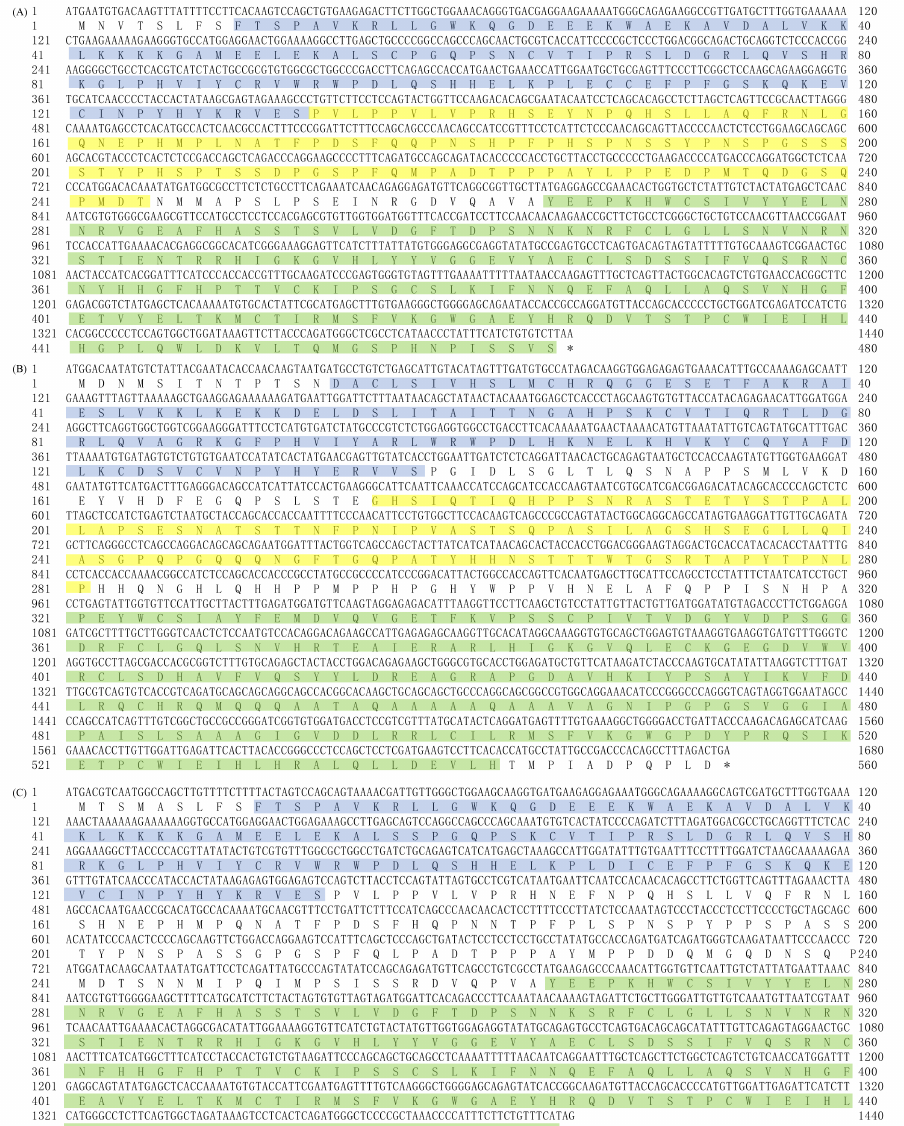
Figure 2. Complete CDSs of buffalo Smads 1 , 4 , and 5 genes and AASs. ( A – C ) exhibit buffalo Smad1 , 4 , and 5 genes, respectively. The shaded parts of blue/yellow/green represent putative conserved functional domains of MH1_SMAD_1_5_9, PRK10263, and MH2_SMAD_1_5_9 in Smad1 , and those of MH1_SMAD_4, Pneumo_att_G, and MH1_SMAD_4 in Smad4 , respectively. The shaded parts in blue/green represent putative conserved functional domains of MH1_SMAD_1_5_9 and MH2_SMAD_1_5_9 in Smad5 , respectively. “*”, termination